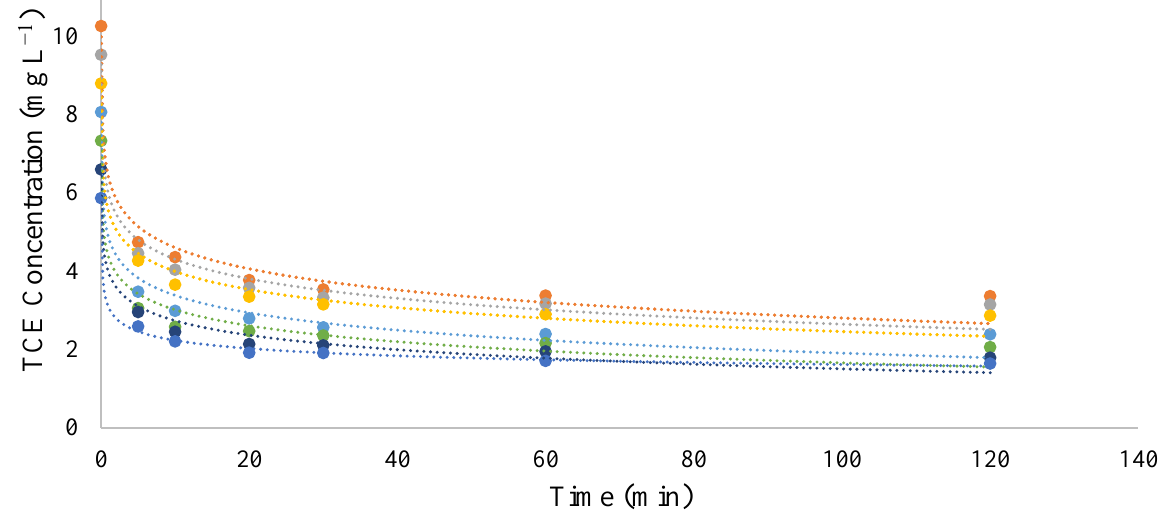
Figure 2. Adsorption experiment of different initial concentrations of TCE by silica gel.